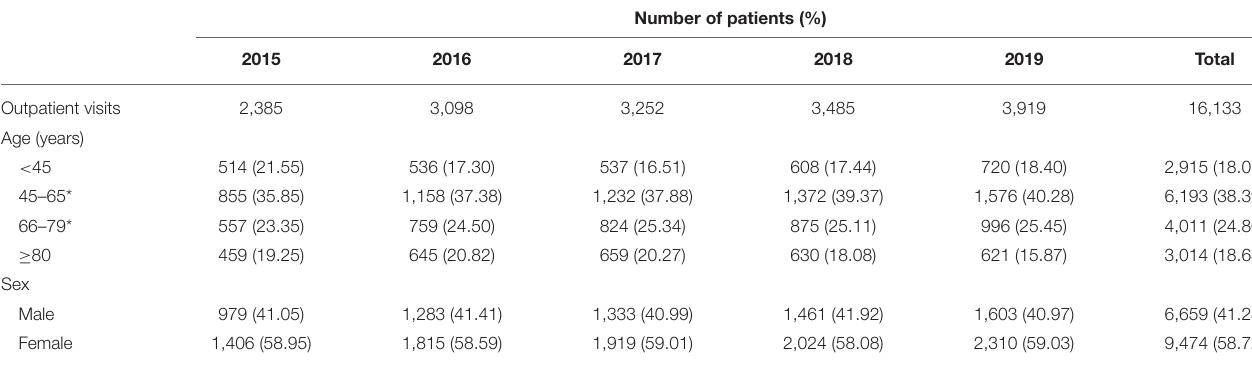
TABLE 1 | Demographic characteristics of outpatients prescribed medications for